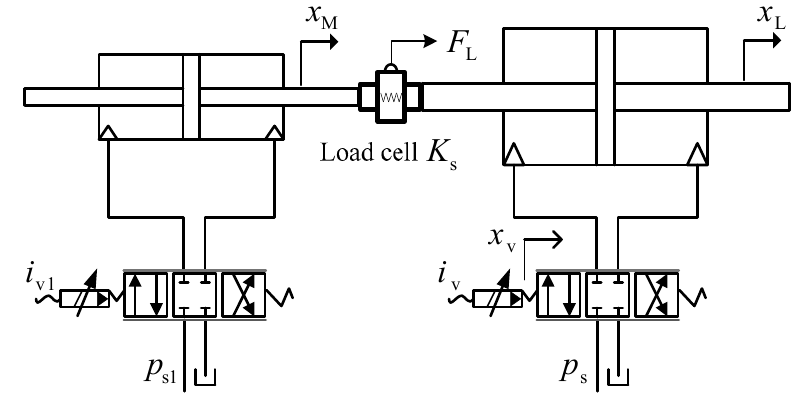
Figure 2. The equivalent schematic diagram for modeling.